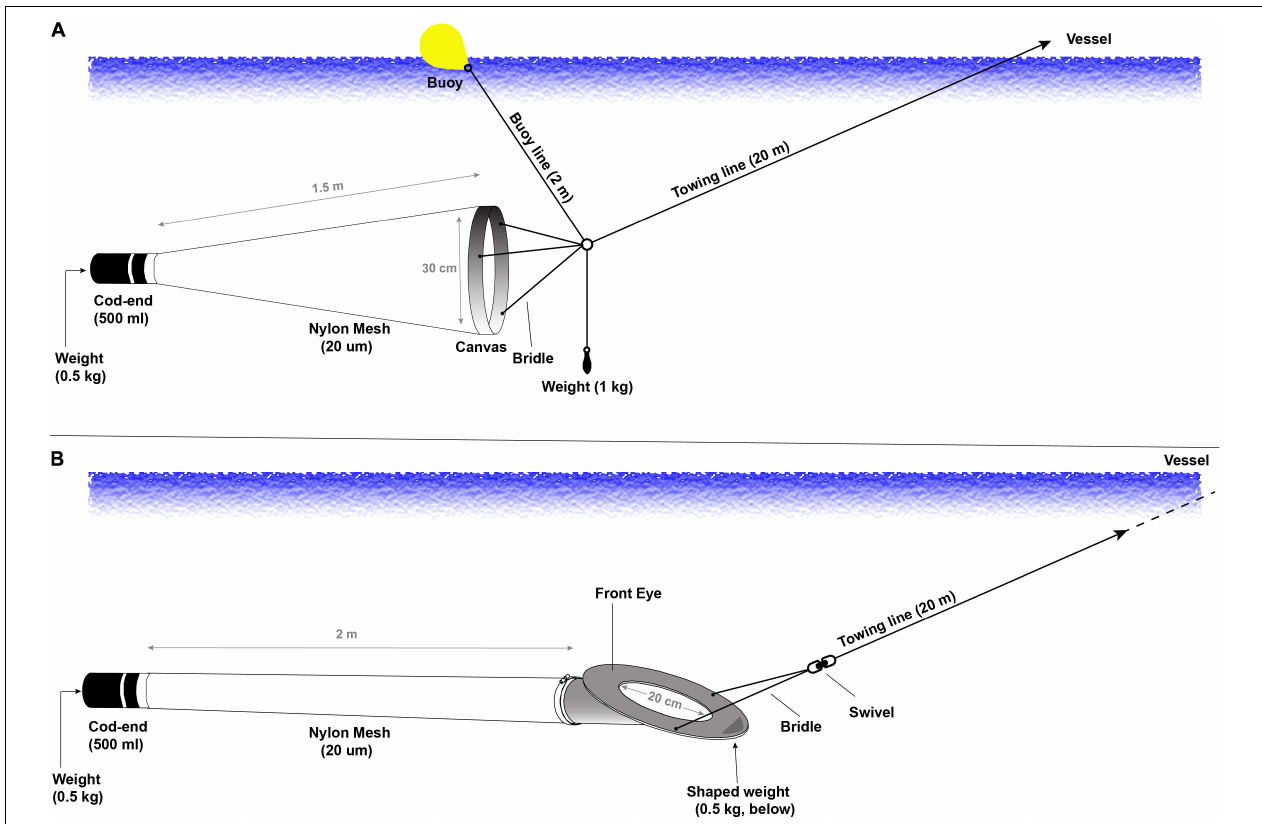
FIGURE 1 | Description of the two plankton sampling devices tested in this study, with (A) the Traditional Plankton Net (TPN) and (B) the Cruising Speed Net (CSN). Complete specifications and general assembly of the CSN are provided in Supplementary Figure 2